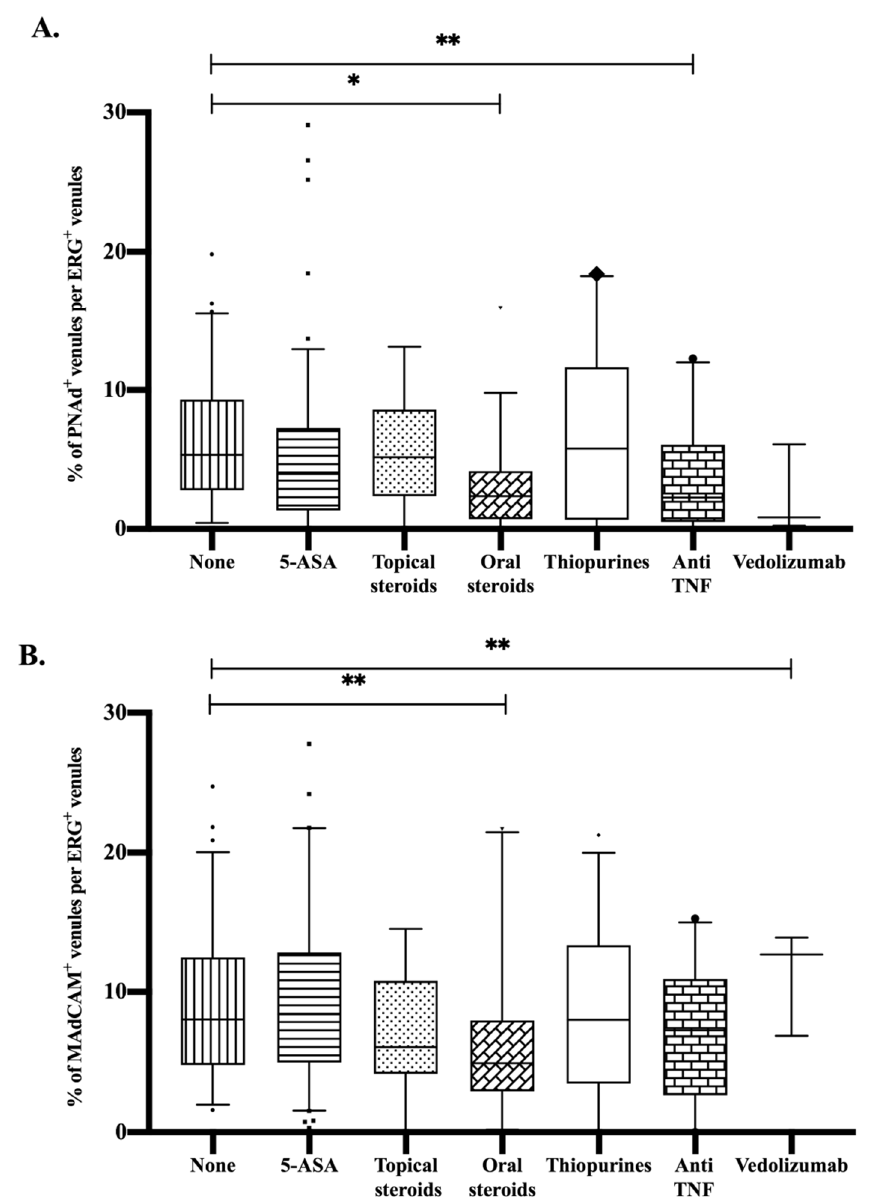
Figure 4. The e ff ect of treatment during follow-up endoscopy on the percentages of ( A ) PNAd +